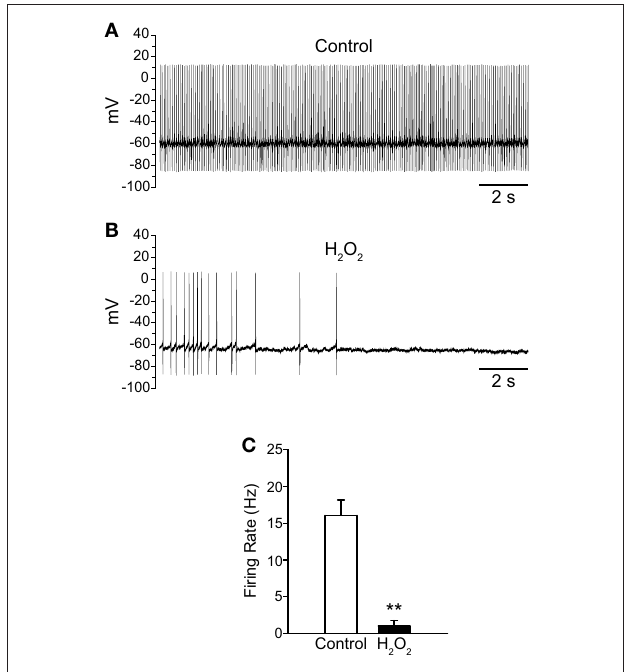
FiGuRe 8 | exogenous H O suppresses the firing of SNr GABAergic 2 2 neurons in mouse slices. (A) Whole-cell current clamp recording from a mouse SNr GABAergic neuron recorded in vitro under control conditions. (B) The same neuron recorded in the presence of exogenous H O (750 μM) 2 2 exhibited decreased firing rate and eventual hyperpolarization leading to cessation of spontaneous firing. (C) H O caused a significant decrease in 2 2 firing rate in SNr GABAergic neurons from mouse. (** p < 0.01).